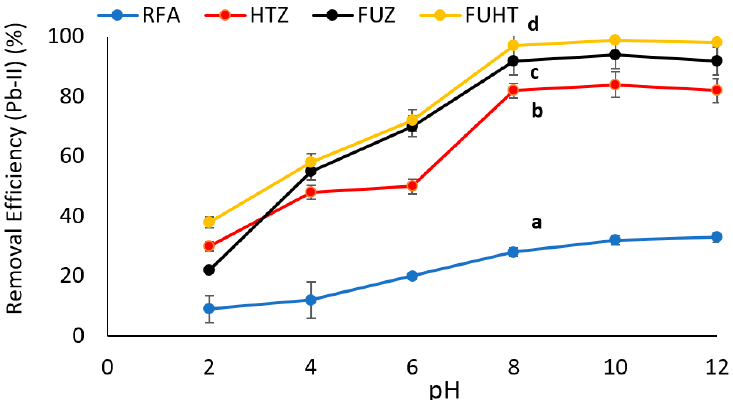
Figure 5. Effect of pH on the removal efficiency of Pb (II) at 100 mg/L metal ion concentration, 1g/100 mL mass of adsorbent (RFA and Na-zeolites), and 30 min contact time at 25 °C. Notes: a,b,c,d shows significant ( p < 0.05) differences among different zeolite samples.